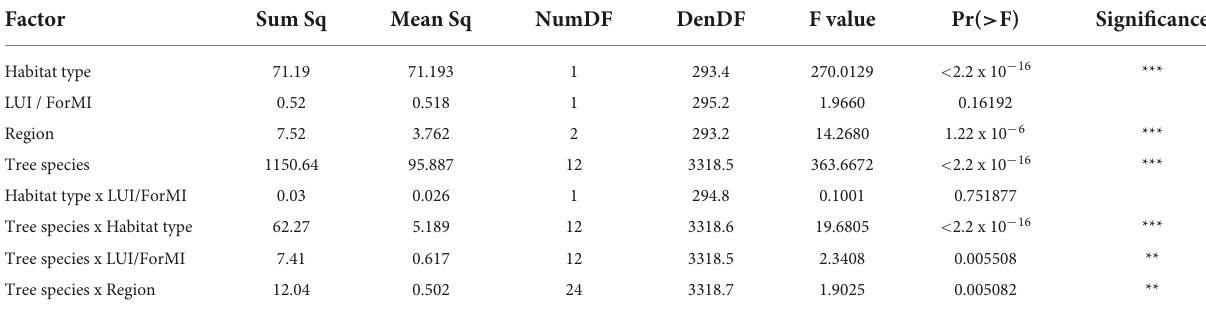
TABLE 2 Results of linear mixed effect model for regions (Schorfheide-Chorin, Swabian-Alb, and Hainich-Dün), habitat types (grassland and forest), management intensity (LUI, land use intensity index or ForMI, forest management intensity) and their interactions on the mass loss of deadwood from 13 temperate tree species (Model 1; n =